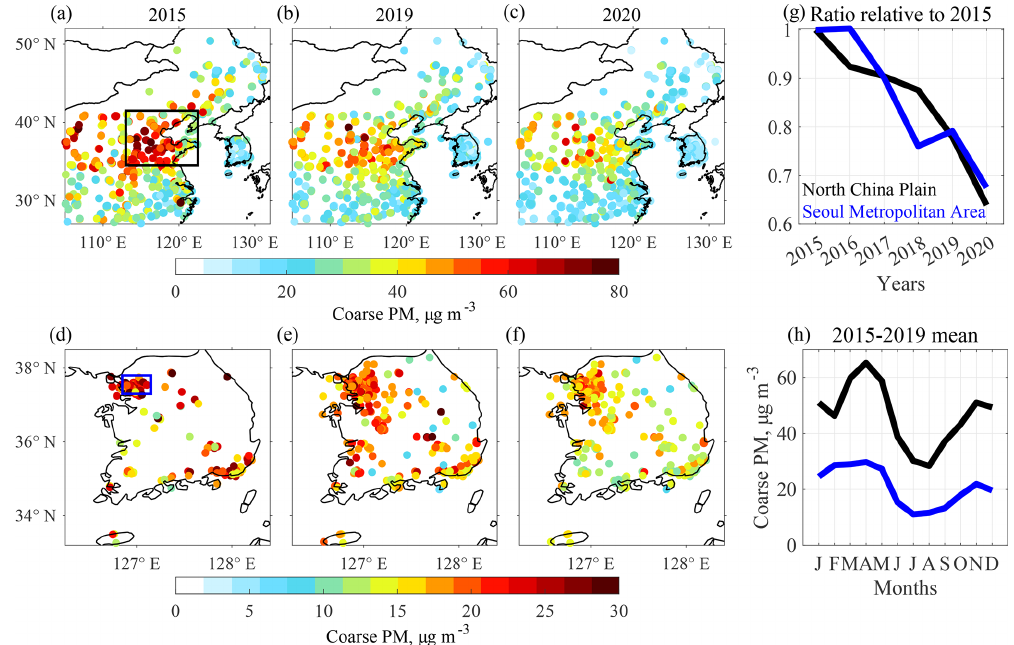
Figure 1. Distributions and trends of coarse PM concentrations over China and South Korea during 2015–2020. Here and elsewhere, coarse particulate matter (PM) is defined as particles between 2.5 and 10µm aerodynamic diameter, and its concentration is determined by subtracting PM 2 . 5 from PM 10 in the air quality network data. Panels (a) – (c) show the annual mean concentrations in 2015, 2019, and 2020 over China and panels (d) – (f) show the same for South Korea. The rectangles in (a) and (d) delineate the North China Plain or NCP (113– 122.5 ◦ E, 34.5–41.5 ◦ N) and the Seoul Metropolitan area or SMA (126.7–127.3 ◦ E, 37.3–37.8 ◦ N). Panel (g) shows annual trends relative to 2015 in the NCP (197 sites) and the SMA (33 sites) averaged over sites with at least 70% data coverage each year from 2015 to 2020. Panel (h) shows the mean 2015–2019 seasonality over the NCP and SMA.